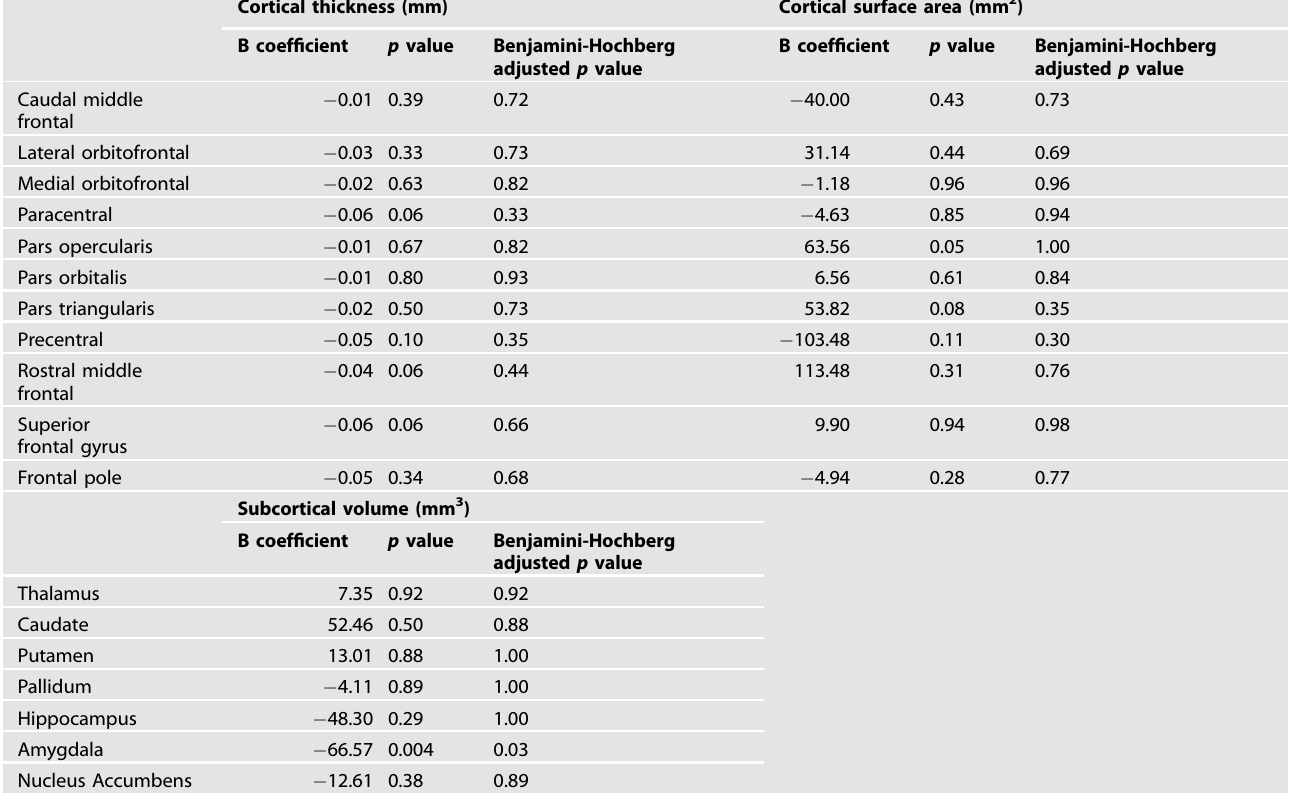
Table 3. Postpartum depressive symptom associations with cortical thickness, cortical surface area, and subcortical